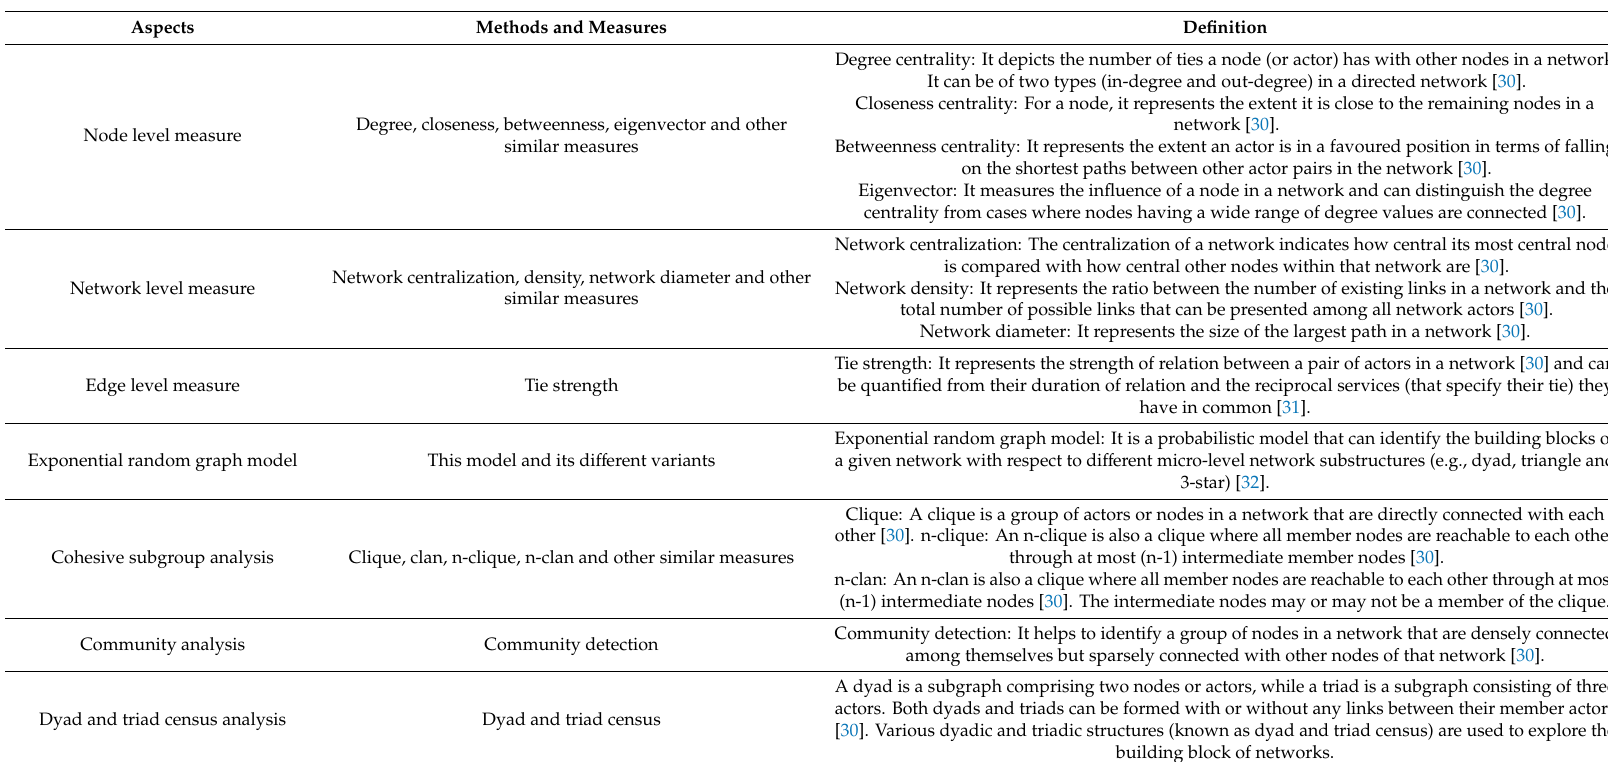
Table 1. Explanation of major network methods and measures across di ff erent